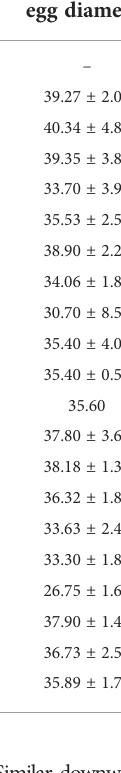
TABLE 1 Distribution of gametogenic stages and egg diameter of females in each family of Crassostrea angulata . family female number